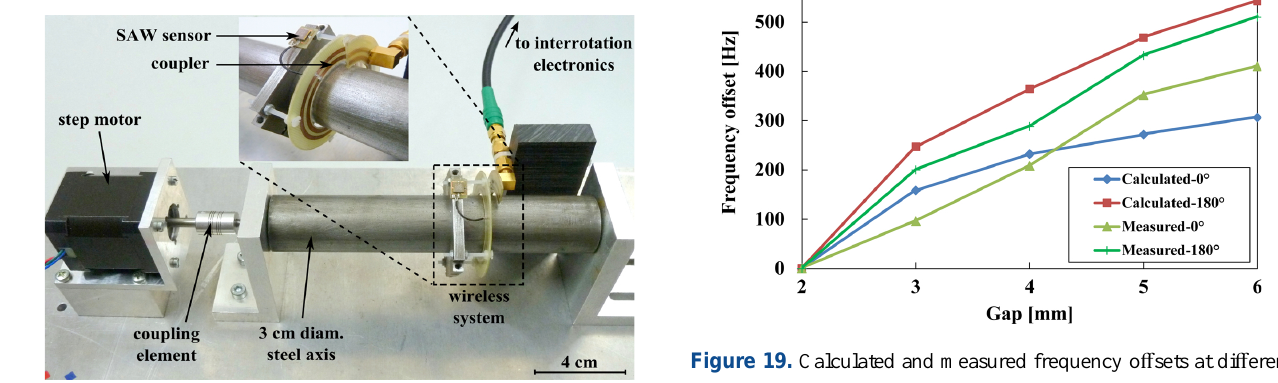
Figure 16. Picture of the bench used for frequency pulling mea- surements. A step motor is coupled to a 3cm diameter steel axis. A dual resonance temperature SAW sensor is fixed on a clamp system and is wirelessly interrogated using the capacitive coupler.